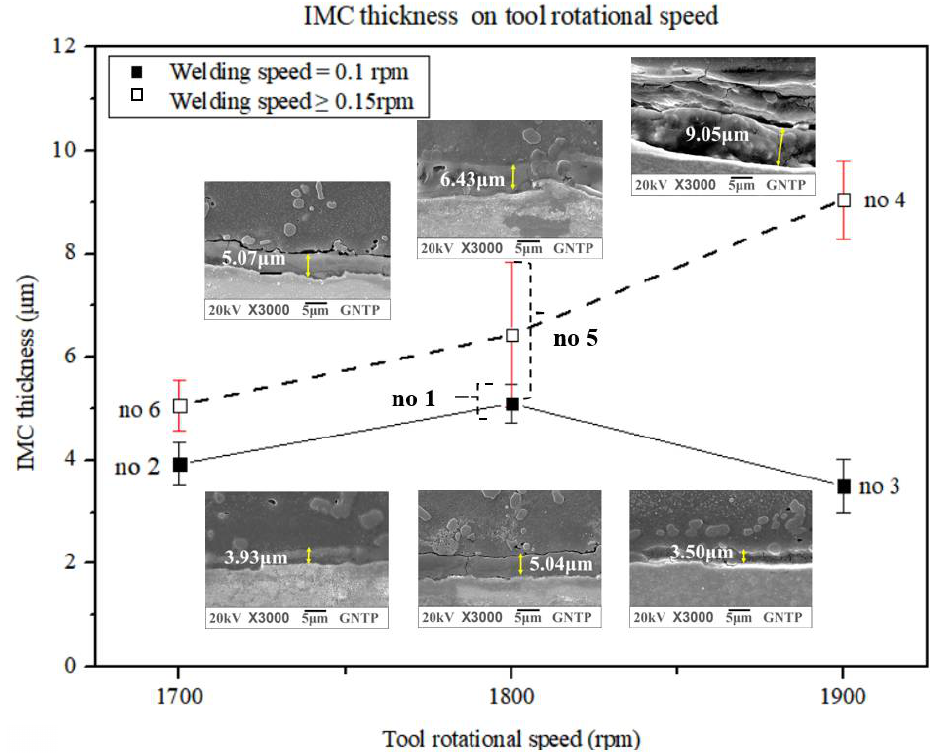
Figure 8. Comparison of IMC thickness for different TRSs of experiment groups A and B.